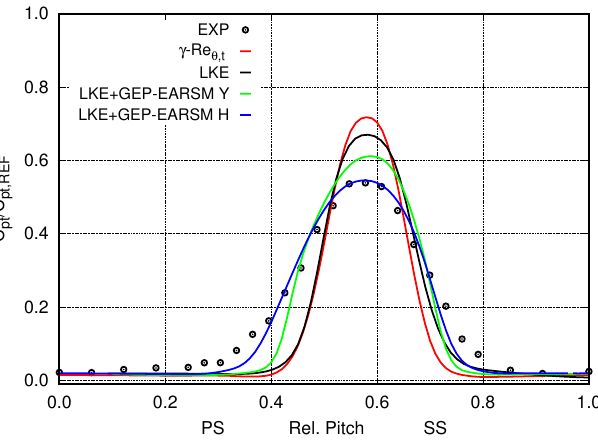
Figure 6. Wake loss profiles w/ and w/o GEP-EARSM ( Re 2, is = 0.7